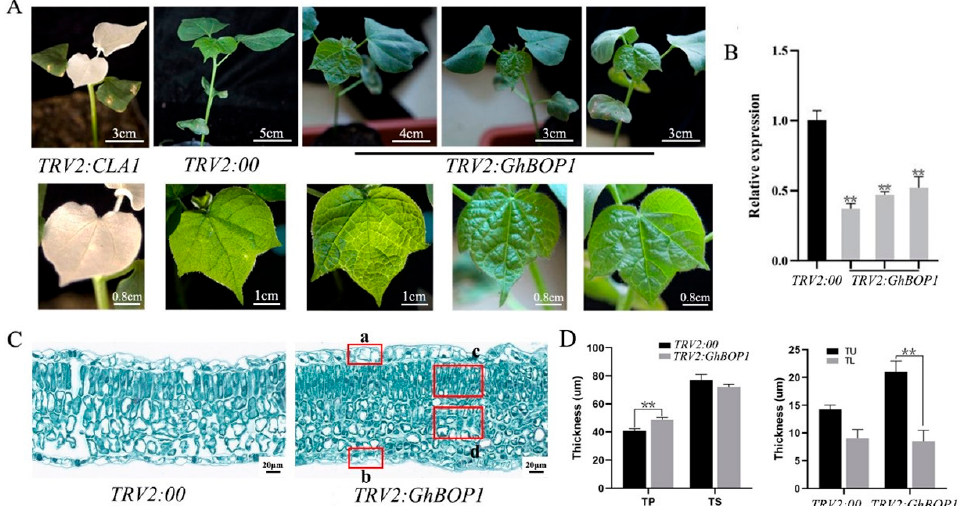
Figure 4. Silencing of GhBOP1 changed the flatness and morphology of cotton leaves. ( A ) Phenotypes of blank control and gene silenced plants. Plants from left to right are positive control ( TRV2:CLA ), negative control ( TRV2:00 ) and three silent GhBOP1 lines ( TRV2:GhBOP1 ). ( B ) GhBOP1 expression level in blank control and VIGS plants. GhHistone3 was used as an internal reference gene for data normalization. ( C ) Paraffin-sectioned phenotypes of leaves of blank control plants and wrinkled leaves of GhBOP1 -silenced plants. a presents the upper epidermal cell, b presents the lower epidermal cell, c presents the palisade tissue, and d presents the spongy tissue (red box). ( D ) Statistics of cell thickness corresponding to the paraffin section of leaves. TU represents the thickness of the upper epidermal cells, TL represents the thickness of the lower epidermal cells, TP represents the thickness of the palisade tissue, and TP represents the thickness of spongy tissue. Asterisks denote statistical significance as follows: ** p ≤ 0.01.